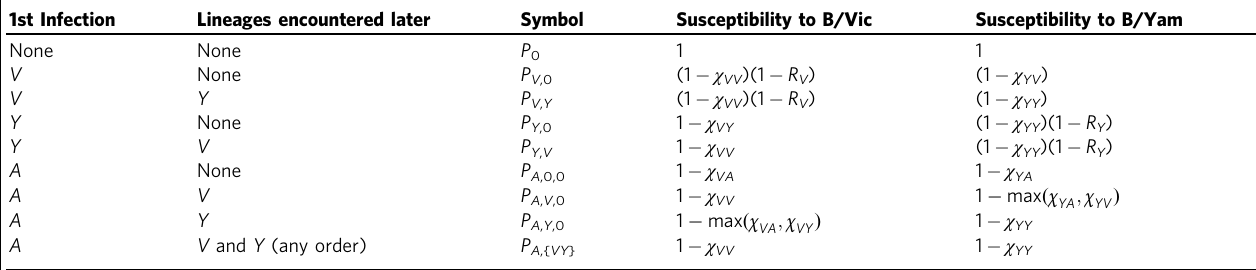
Table 1 Possible infection histories in terms of the lineage of fi rst infection and lineages encountered since.